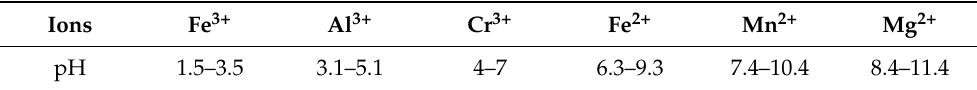
Table 7. pH of different metal ions upon hydroxide precipitation (25